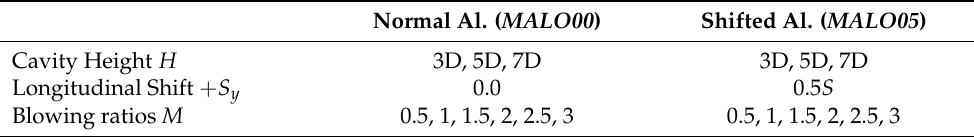
Table 1. Overview of geometrical test arrangements.